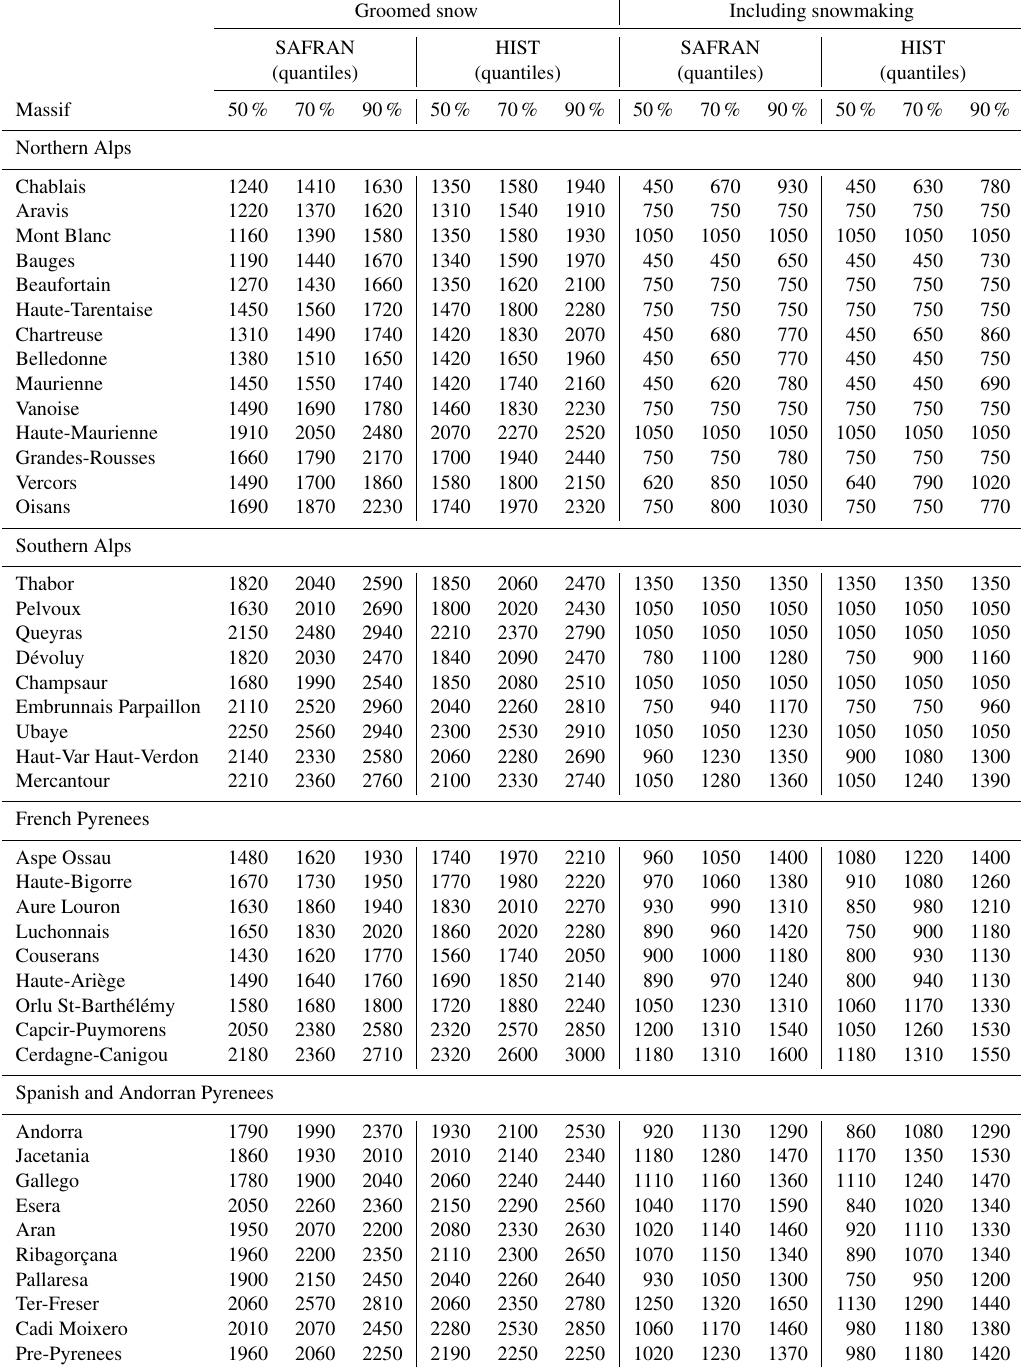
Table A1. Snow reliability elevation for the reference period (1986–2005) for the 42 massifs distributed over the northern Alps, southern Alps, French Pyrenees, and Spanish and Andorran Pyrenees, computed by the reference dataset (SAFRAN) and the climate models (HIST) for three distinct reliability requirements (50%, 70% and